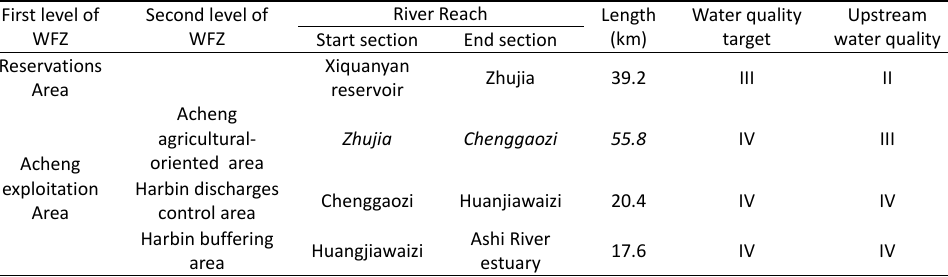
Table 1. Basic information of Ashi River WFZ and water quality objectives Table 1: Basic information of Ashi River WFZ and water quality End section